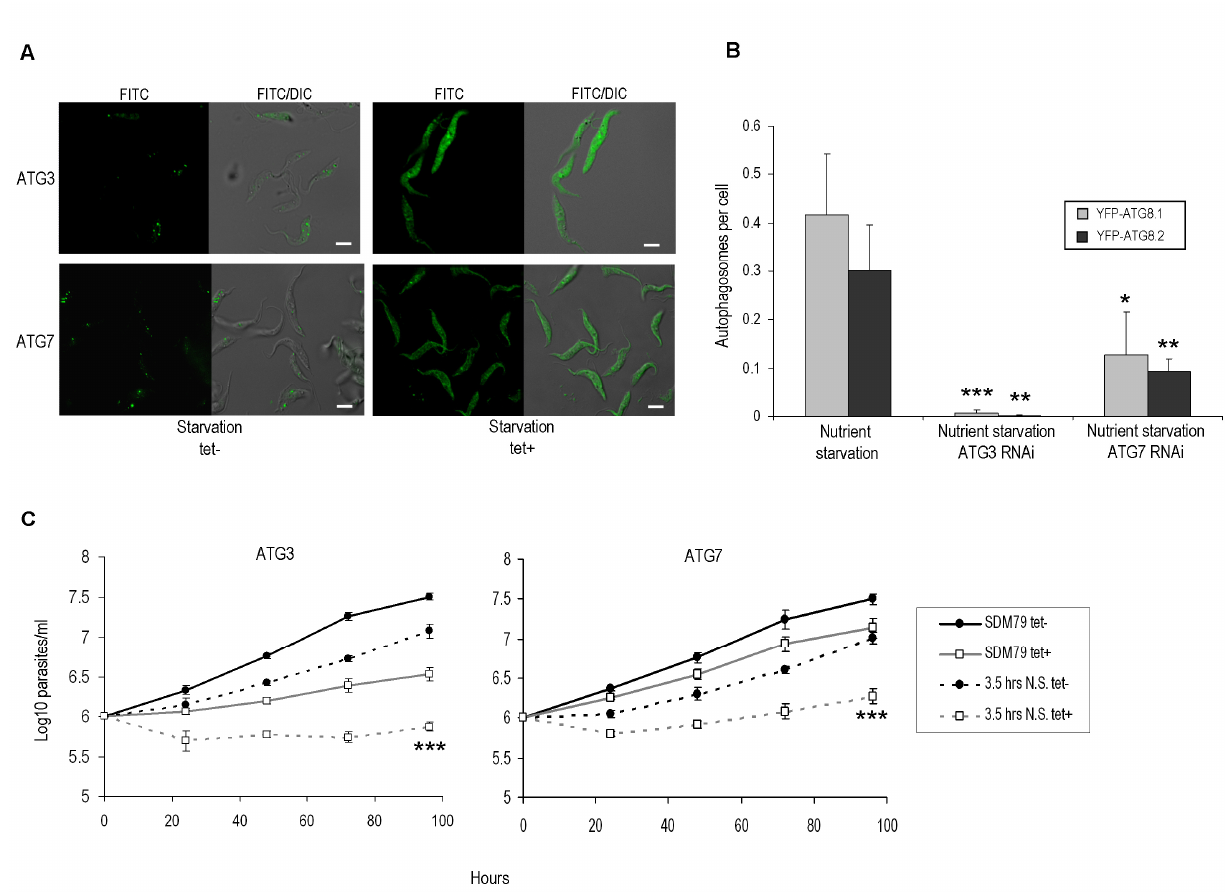
FIGURE 2: Procyclic form ATG3 and ATG7 RNAi mutants. Constitutive expression of YFP-ATG8.1 and YFP-ATG8.2 in PCF was visualised by flu- orescent microscopy following RNAi of either ATG3 or ATG7 for 72 h before nutrient starvation in PBS for 2.5 h. (A) Representative images, left hand images FITC filter set, right hand images DIC FITC merge. Scale bar 5 µm. (B) The mean number of autophagosomes per cell was de- termined by counting >200 cells with data displayed as a mean of three replicate experiments. Error bars represent standard deviation and asterisks indicate where data differed significantly from the means of uninduced controls *p<0.05, ** p<0.01, ***p<0.001. (C) ATG3 and ATG7 RNAi was induced for 72 h in cells expressing YFP-ATG8.1 before nutrient starvation for 3.5 h in PBS (dashed lines) or control treatment in SDM79 media (solid lines). Cells were re-seeded at 0 h in SDM79 + tet (empty boxes grey line, tet+) and SDM79 –tet (filled boxes black line, tet-) and growth was determined daily for 96 h. Data represent mean of three replicate experiments. Error bars show standard deviation and asterisks indicate where data differed significantly from the means of tet induced starved and non-starved lines at the 96 h time point